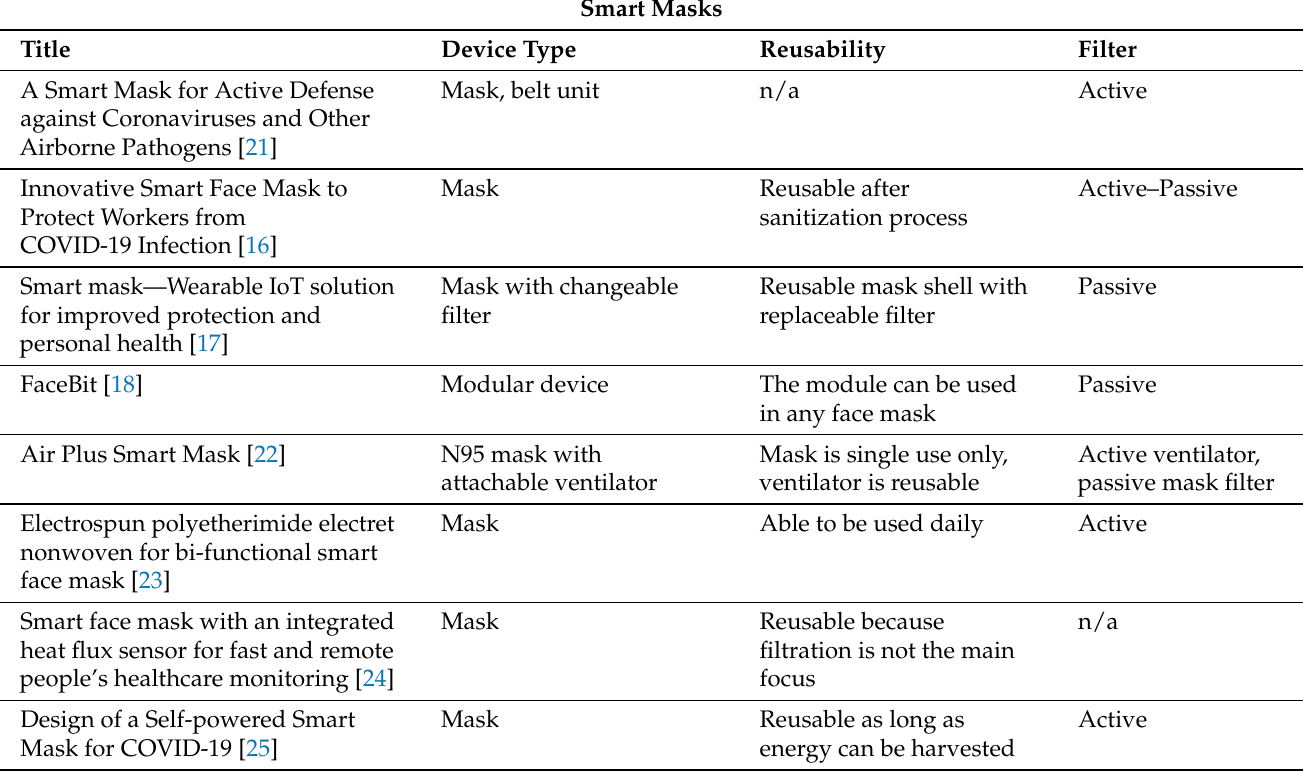
Table 1. Evaluation of Related